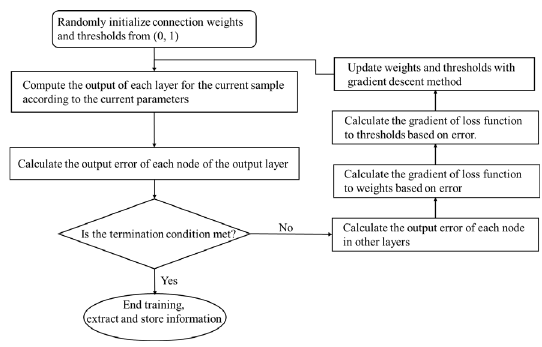
Figure 4. The workflow of a BP neural network algorithm.